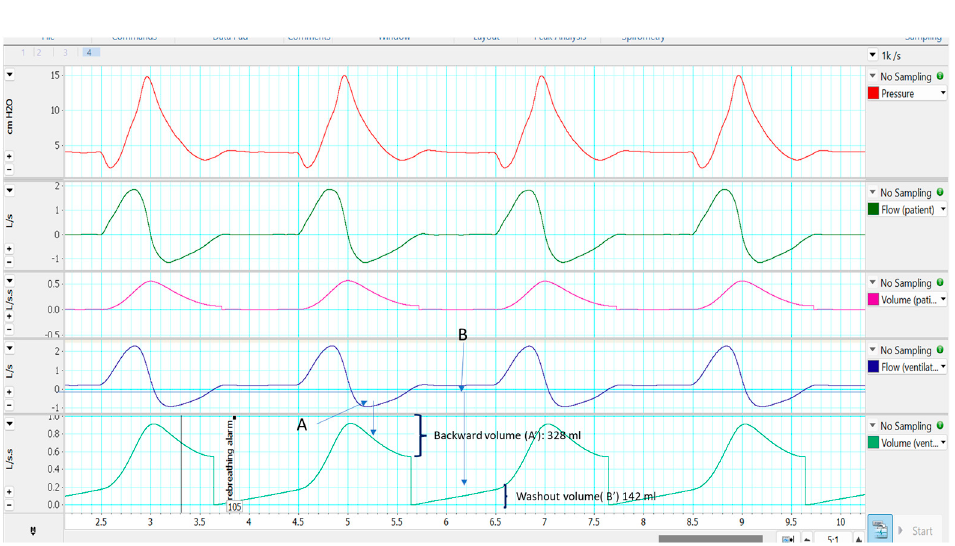
Figure 4. Example of rebreathing. See the text for more details.